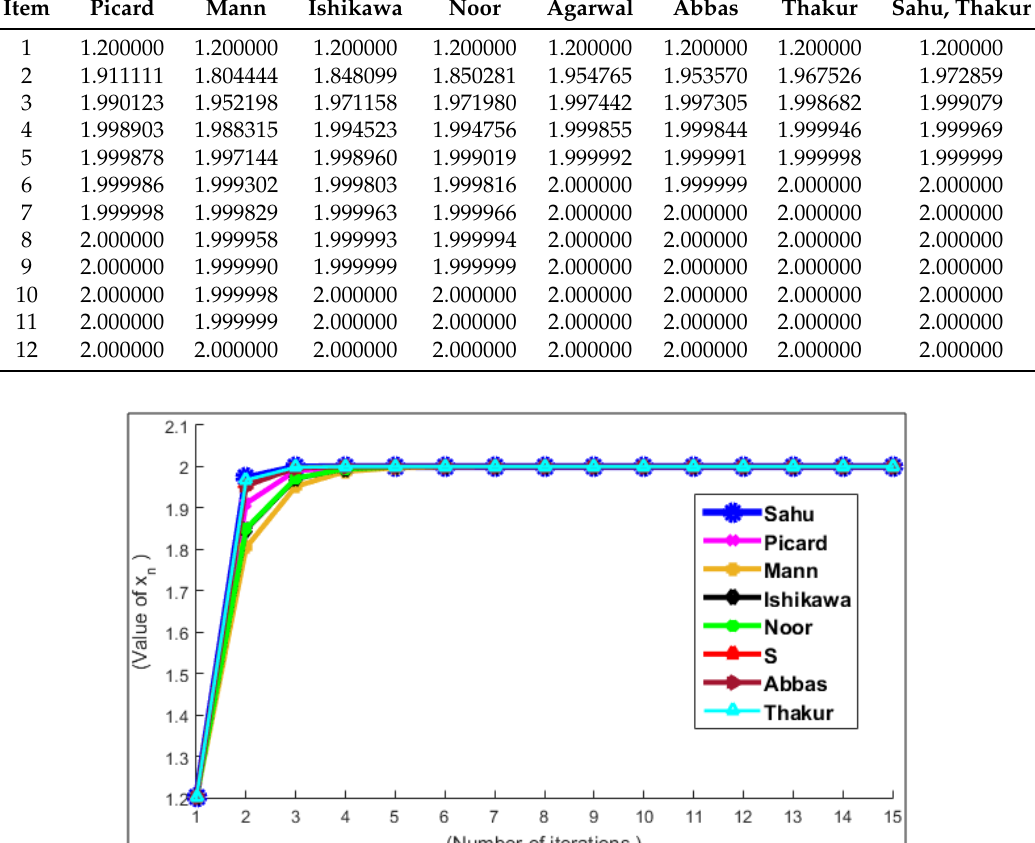
Figure 1. Convergence behavior of Sahu iterative scheme with other iterative